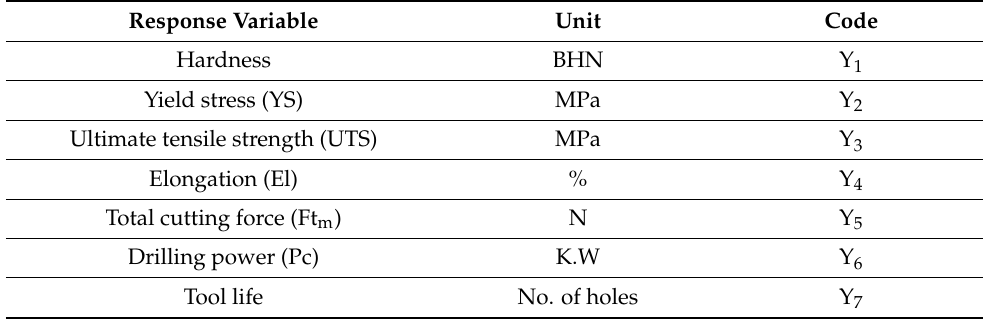
Table 2. Response variables and